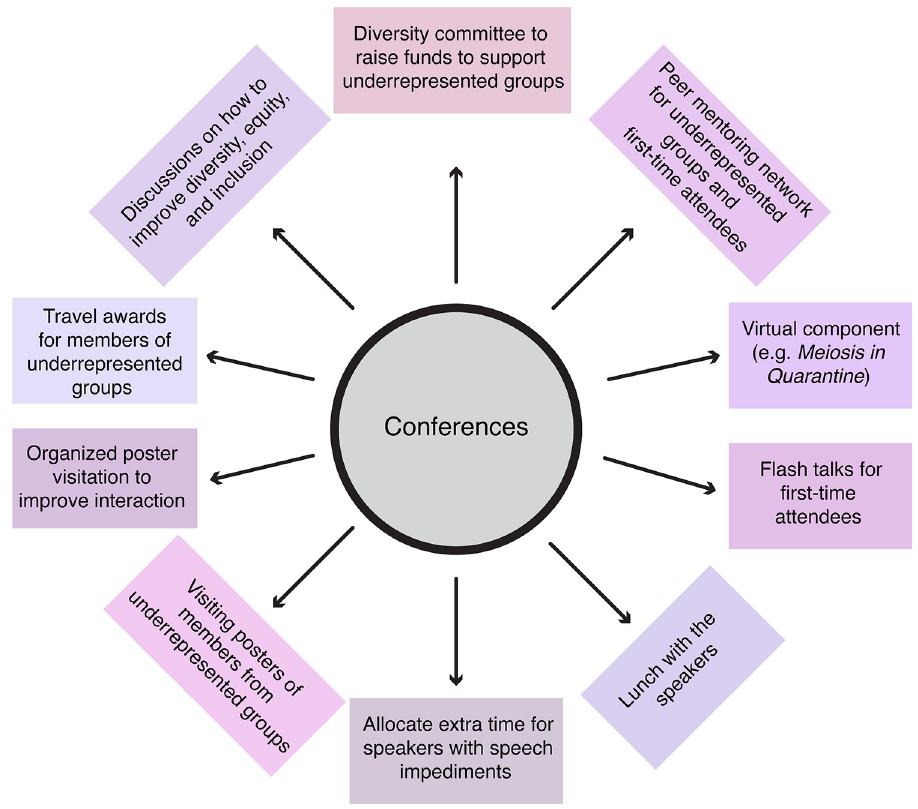
Fig 1. Concrete examples to promote diversity and inclusion at conferences. These are action items for future conferences that were discussed during the ‘Meiosis in Quarantine’ equity and inclusion